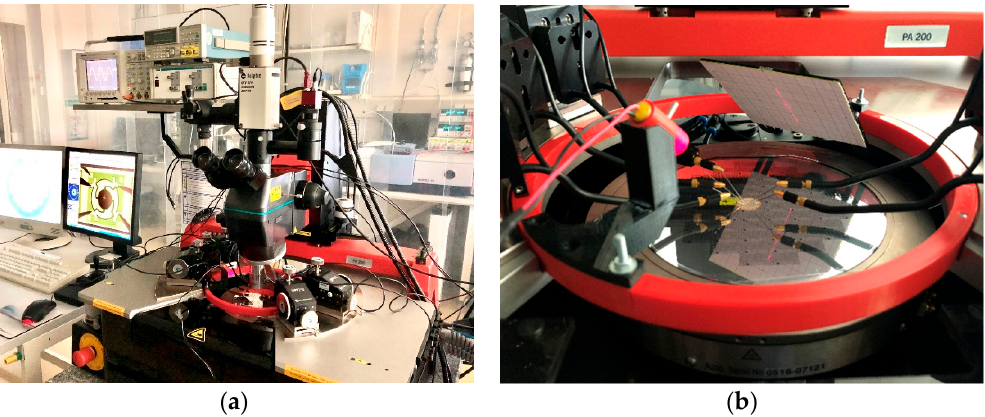
Figure 12. Photograph of the optical test setup: ( a ) Entire setup around the automated probe bench station; ( b ) Integrated probe bench adapter with laser source holder and scaled screen.